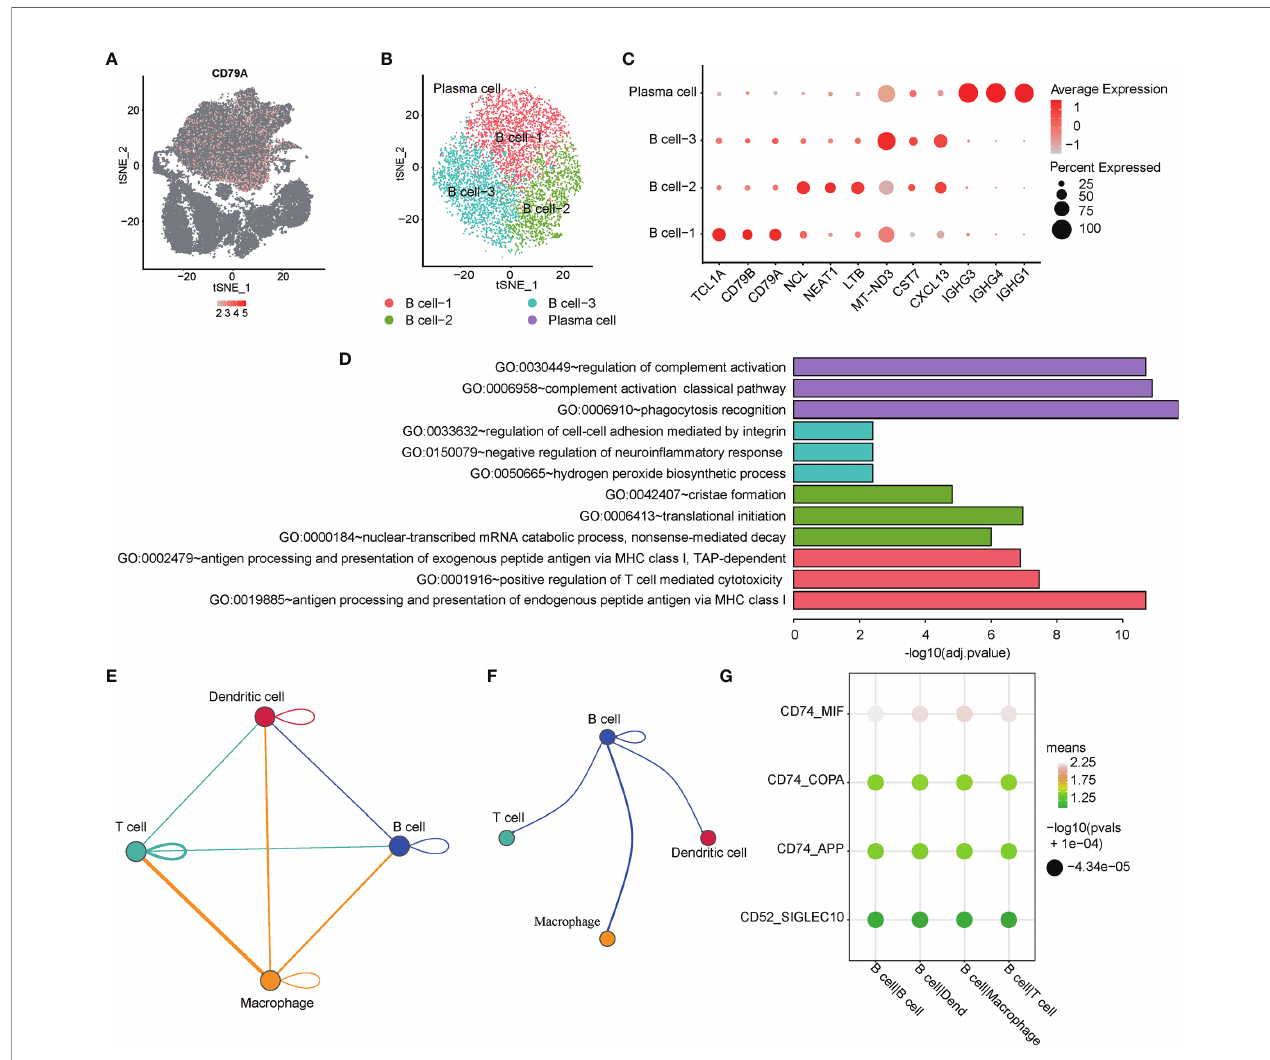
FIGURE 2 | Single-cell analysis of heterogeneity for B cell and cell communication. (A) The expression distribution of the B cell maker gen – CD79A in all cells. (B) tSNE visualization describes the re-cluster results of B cell subgroups. (C) The bubble chart shows that selected three marker genes are selected for each cell subgroup, and their expression in all cell subpopulations is plotted. (D) The top3 representative GO functional annotation categories of marker genes for each sub-population. (E) The interactions among immune-related cell subpopulations: B cell, T cell, macrophage, and dendritic cell subpopulation. (F) The interaction pairs of B cell with T cell, macrophage, and dendritic cell, respectively. (G) The ligand-receptor pairs are contributing to the signaling from B cells to the other three